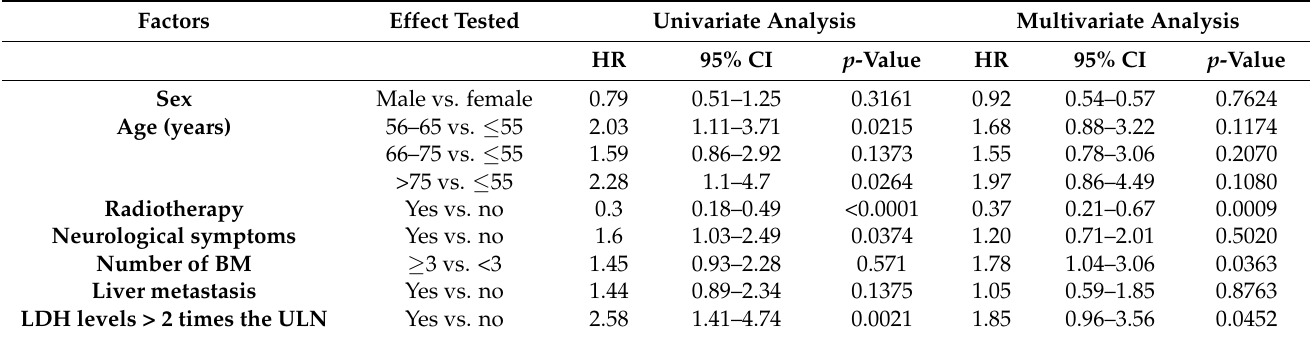
Table 4. Results of Cox regression for overall survival.